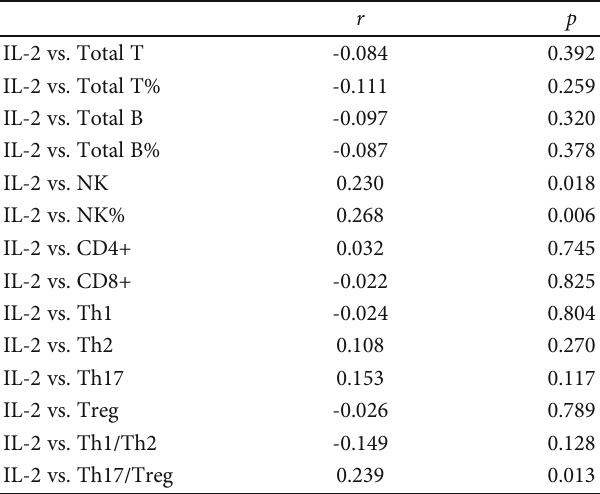
Figure 5: Heatmap of correlation of the serum cytokine levels of IL-2, IL-4, IL-6, IL-10, INF- γ , TNF- α with Total T, Total T%, Total B, Total B%, NK, NK%, CD4+, CD8+, Th1, Th2, Th17, Treg, Th1/Th2, and Th17/Treg ( ∗ p < 0 : 05 , ∗∗ p < 0 : 01 , and ∗∗∗ p < 0 : 001 by Spearman ’ s correlation test). Table 5: Relationship between serum IL-2 level and peripheral blood lymphocytes and CD4+ T